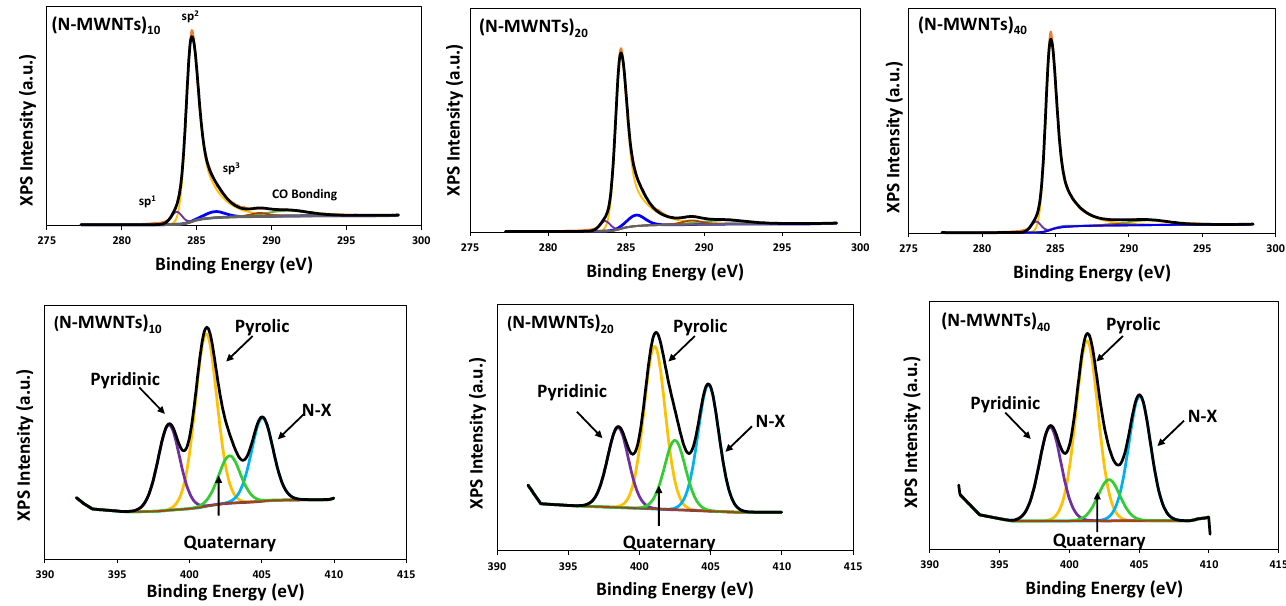
Figure 2. XPS Spectra and C1s and N1s of N-doped CNTs synthesized using different ratios of catalyst.